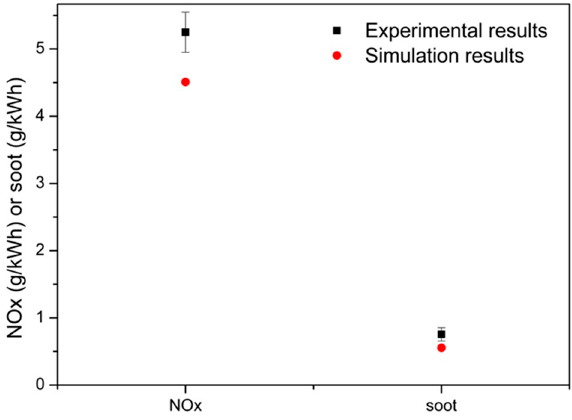
Figure 5. Comparison of engine out NO x and soot emission between simulation and experiment results.